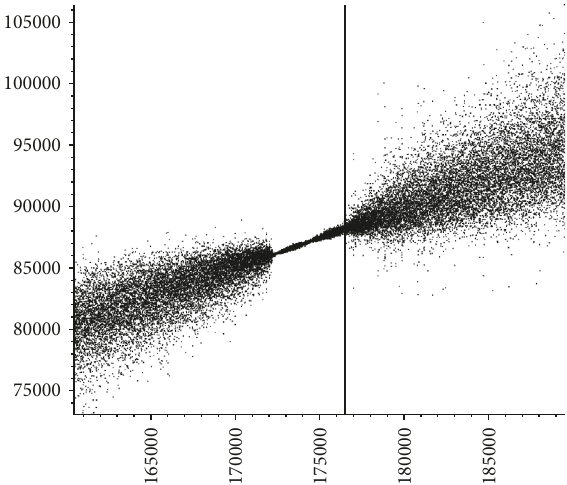
Figure10:Illustrationof 𝑃(17) = 176507 onthescatterplotof 𝑄 𝑏 (𝑛)